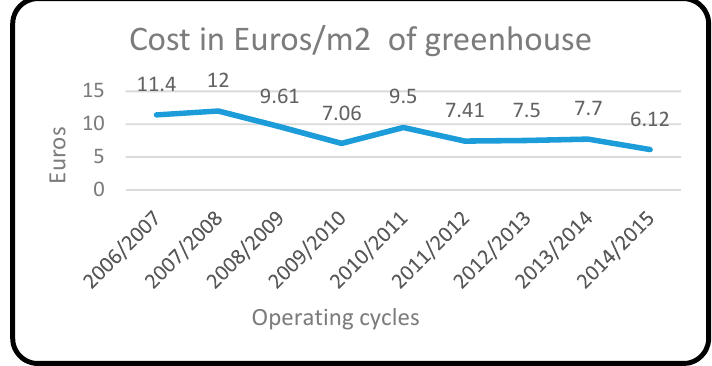
Figure 8. Greenhouse costs. Source: fieldwork. Table 4. Average operational costs in greenhouses 2002–2015. Source: fieldwork.